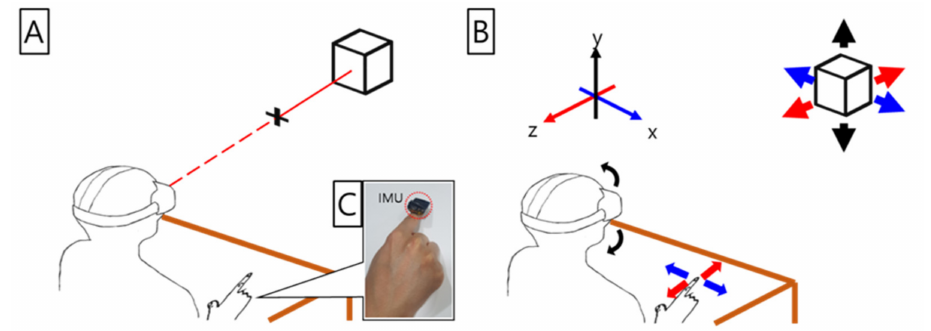
Figure 1. Conceptual diagram of manipulating a virtual object: An interaction that combines touch interaction and head movements in a mobile augmented reality (AR) environment on a head-mounted display (HMD). ( A ) The user can select the virtual object with ray casting using touch interaction and head motion. ( B ) The user can manipulate the selected virtual object using touch interaction and head motion. ( C ) A picture of the index finger on a nail-mounted internal measurement unit (IMU)